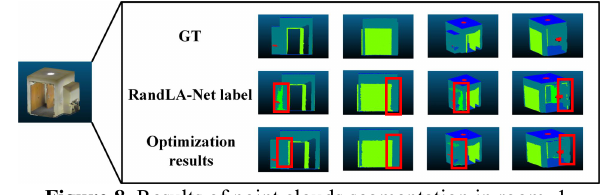
Figure 8. Results of point clouds segmentation in room_1.